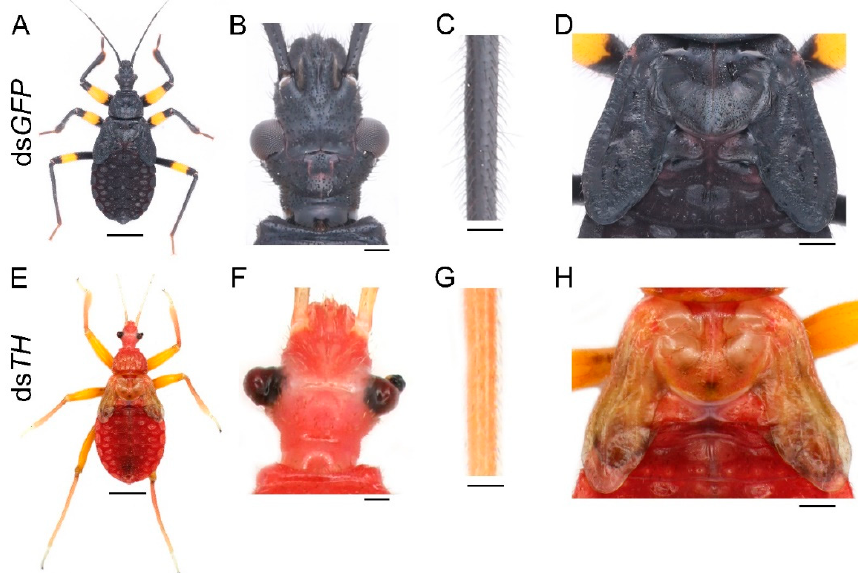
Figure 2. Functions of TH in P. biguttatus nymphs. Nymphs treated with ds GFP showed normal pigmentation patterns ( A ), well-developed cuticles ( B , D ), and bristles ( C ). The ds TH nymphs displayed nearly a complete loss of black pigment, with yellow pigment not affected ( E ). The deformed compound eyes and white bristles on the head ( F ). The short and limp bristles on the tibia ( G ). The wrinkled wing discs and some dark brown markings on the cuticle ( H ). Scale bars, 5 mm ( A , E ), 500 µ m ( B , F ), 250 µ m ( C , G ), 1.25 mm ( D , H ).